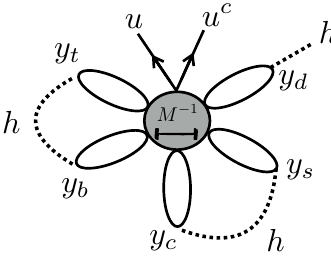
Figure 2 . An instanton contribution to the up quark mass in the SM at high energies. All six quark (cid:13)avors appear, and the non-vanishing contributions are proportional to the products of all the Yukawa couplings. For M v , diagrams with the Higgs looped o(cid:11) are more important than (cid:29) Higgs vev insertions.